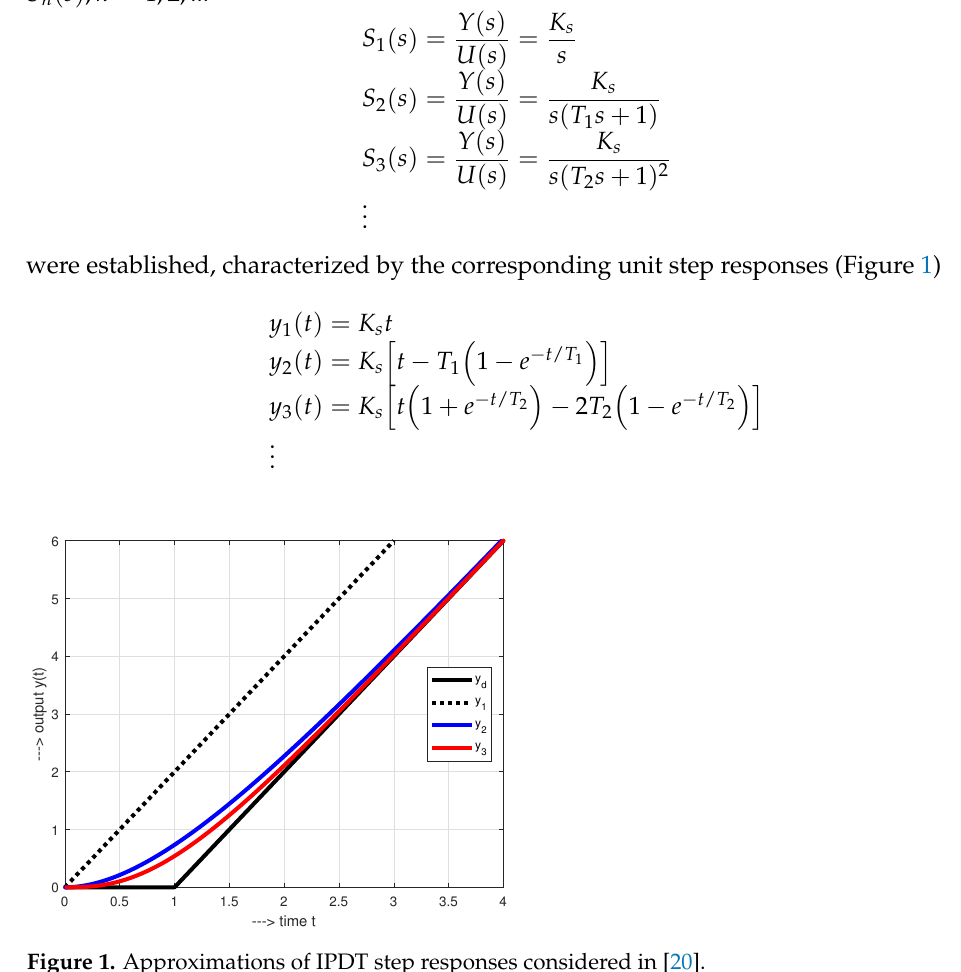
Figure 1. Approximations of IPDT step responses considered in